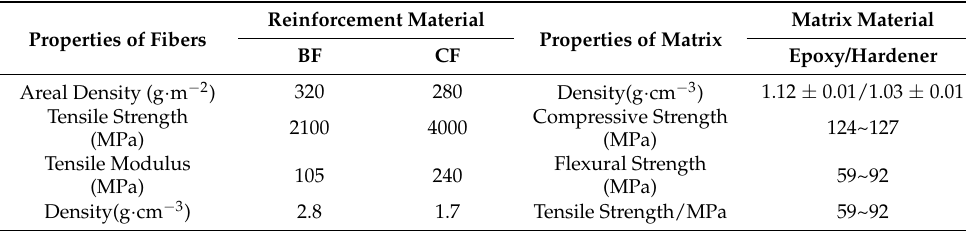
Table 2. Properties of